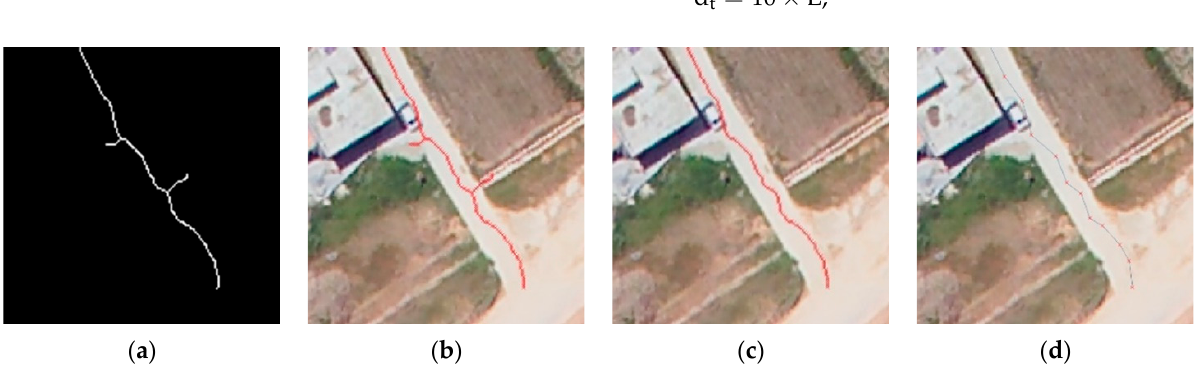
Figure 7. Vectorization to obtain segments: ( a ) result after thinning; ( b ) result after applying the tracking algorithm; ( c ) result after deleting overly short segments; ( d ) result after simplification.